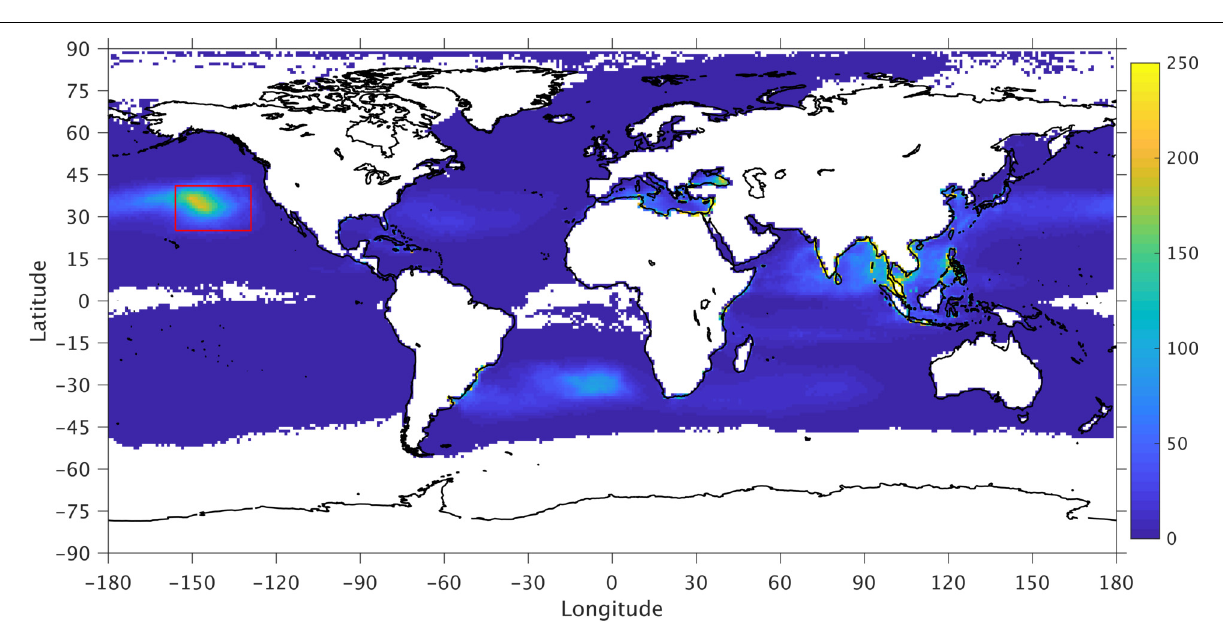
Frontiers in Marine Science |